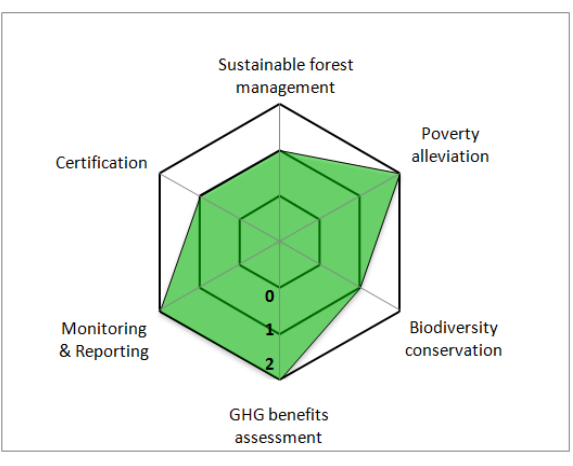
Figure 8. Summary of Plan Vivo